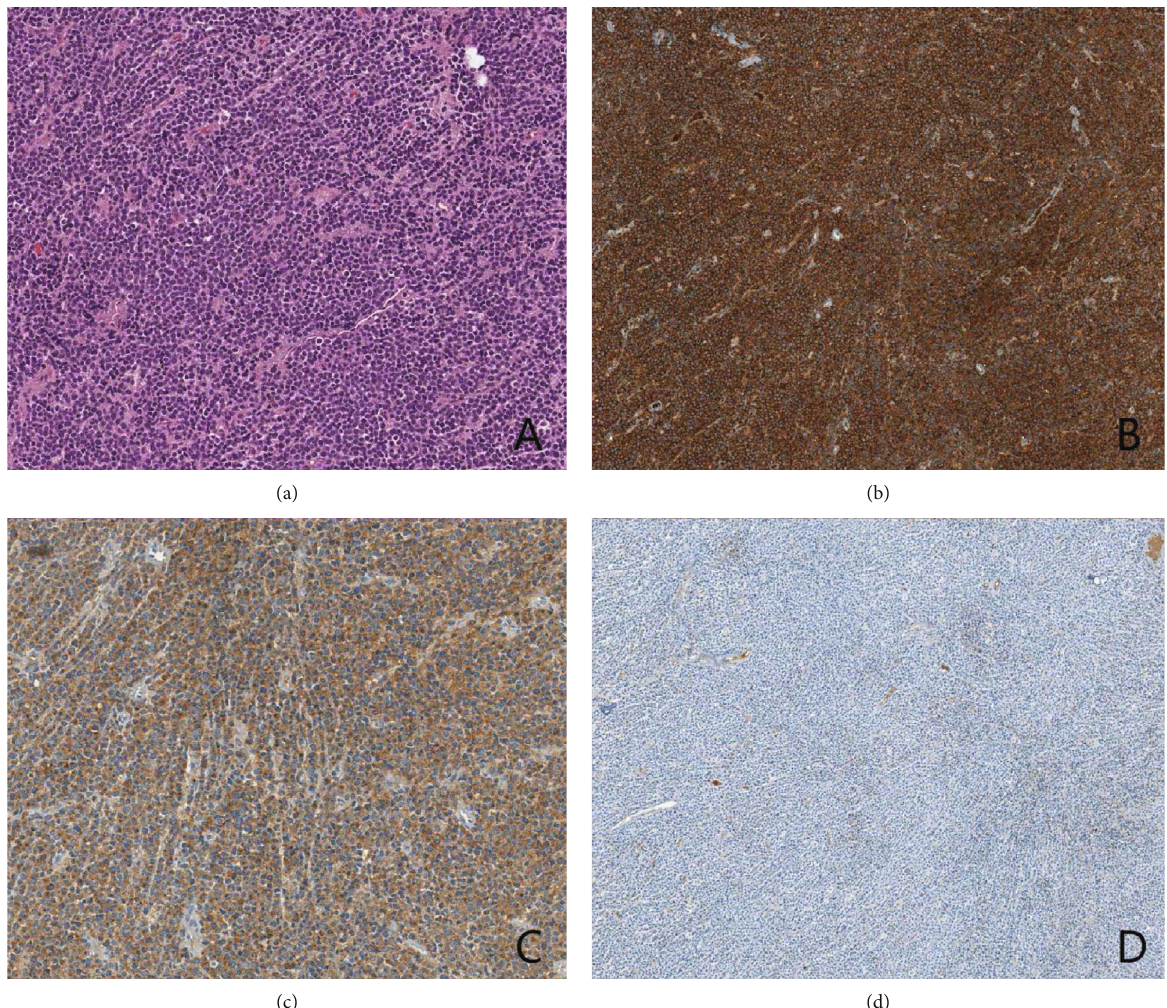
Figure 2: Microphotography showing sheets of atypical plasma cells (a). (HE, 100x). Immunohistochemical staining shows that the tumor cells were positive for CD138 (b), positive for lambda (c), and negative for kappa